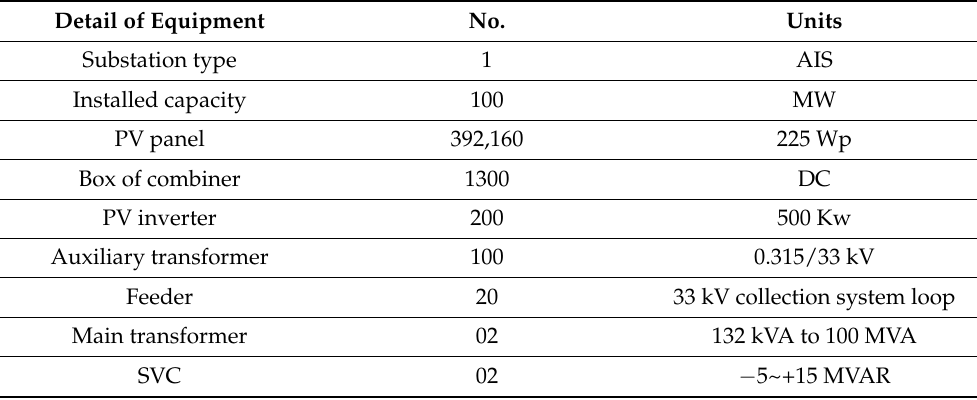
Table 1. Technical description of the solar